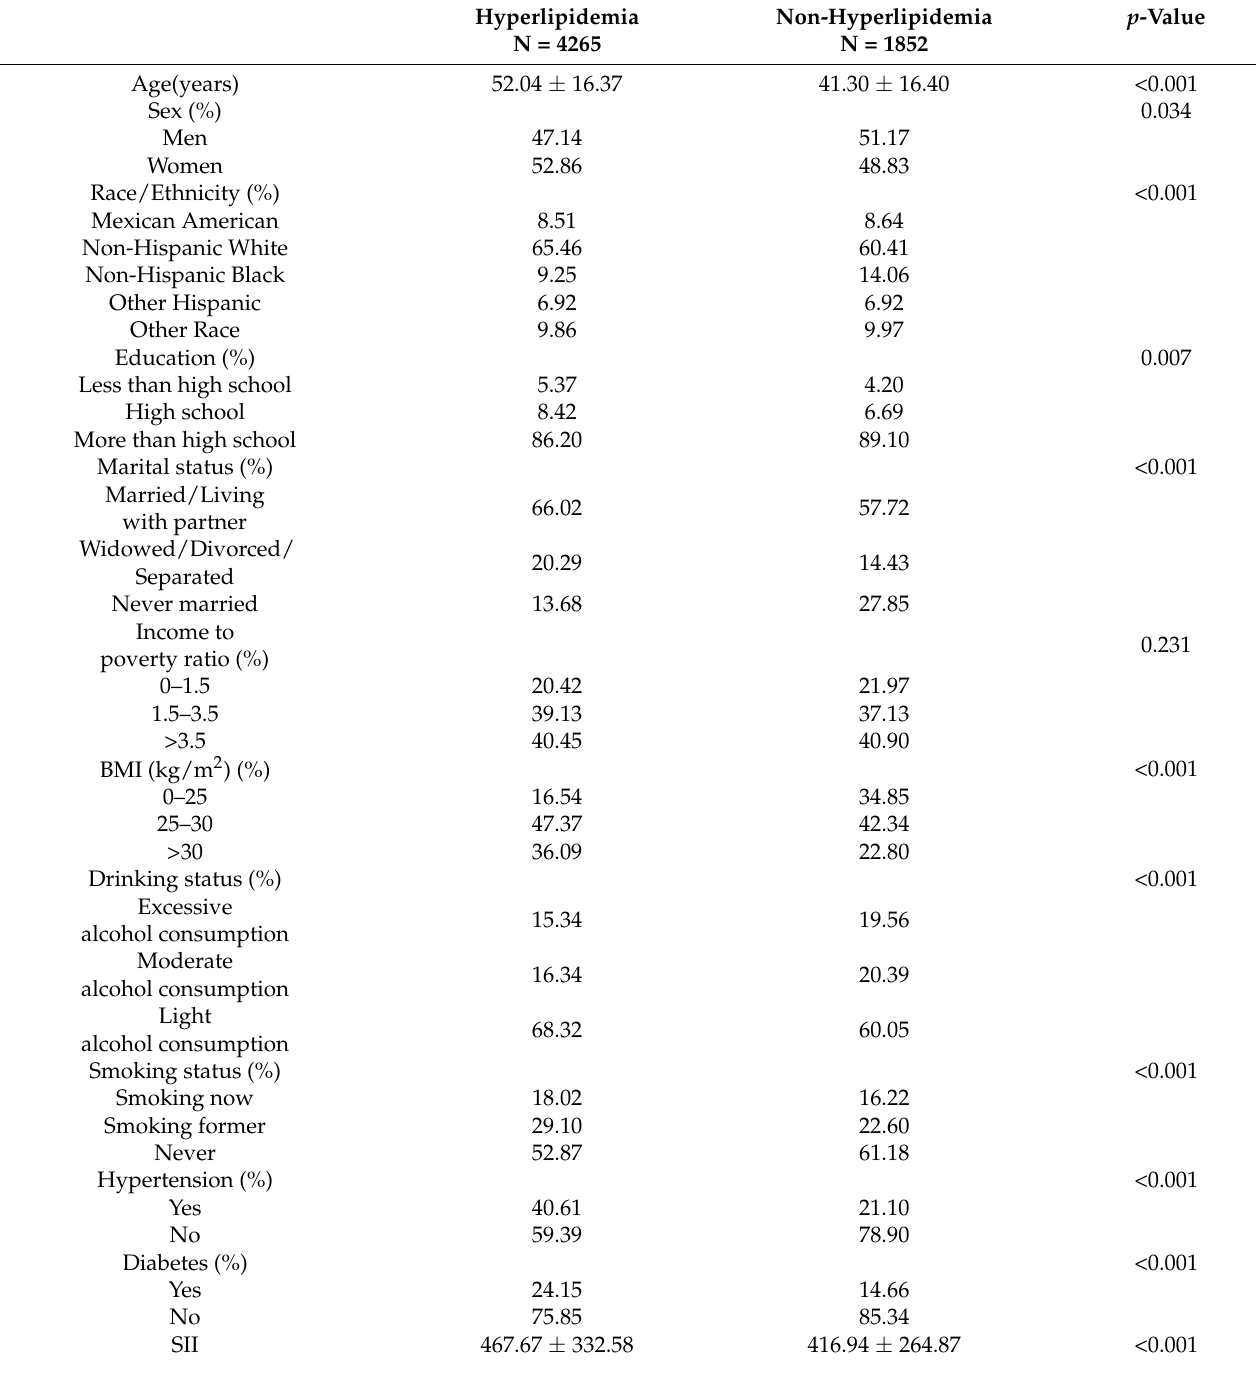
Table 1. Weighted characteristics of the study population based on